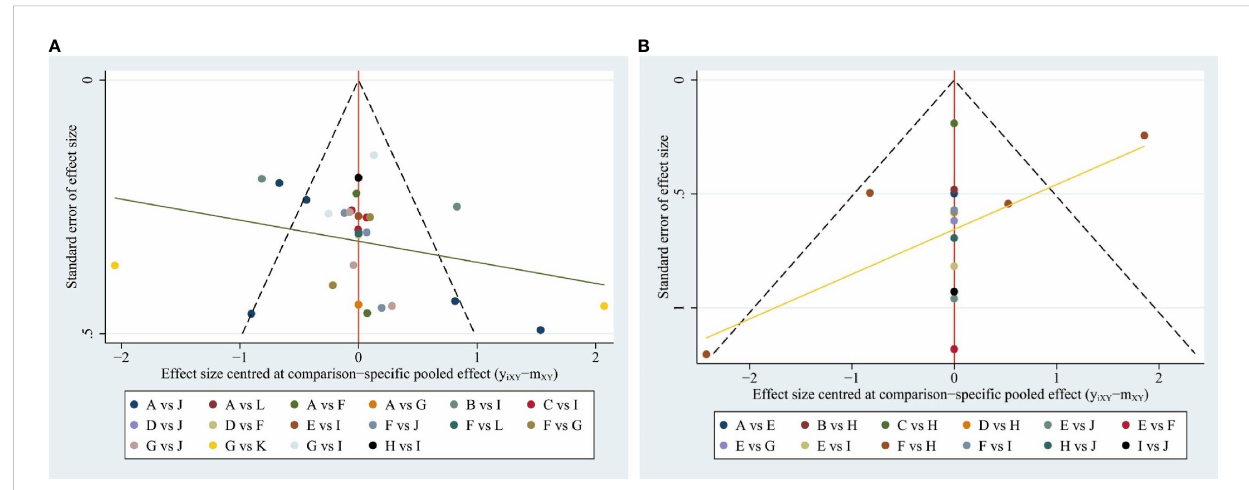
FIGURE 7 (A) Funnel plot for the network meta-analysis in CFS; (B) Funnel plot for the network meta-analysis in PSQI.